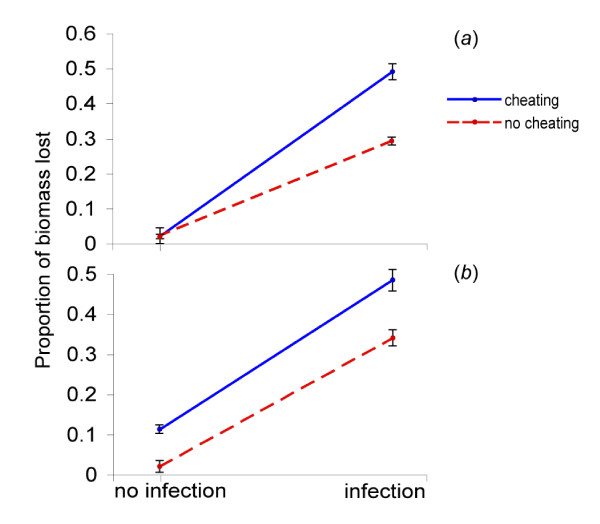
Cheating/infection experiments. Two-way interaction graph illustrating the impact of experimental infection and cheating ants or mutualistic fungi on the garden biomass in two types of fungus-growing ant colonies. A) Trachymyrmex cf.zeteki sub-colonies (n = 40), treated with crossing the presence/absence of fungus garden infection with the presence/absence of cheating ants, shows significantly higher loss of garden biomass when exposed to cheating and infection simultaneously than in all other treatments (2-way ANOVA p < 0.001 df = 3). B) Atta colombica sub-colonies (n = 80), crossing the presence absence of fungus garden infection with the presence/absence of cheating fungi, shows a significantly greater loss in garden biomass when cheating and infection are experienced simultaneously than in all other treatments (2-way ANOVA p < 0.001 df = 3). Non-parallel lines shown in 'A' and 'B' illustrate significance (2-way ANOVA analyses) of the interaction between infection and cheating treatments.